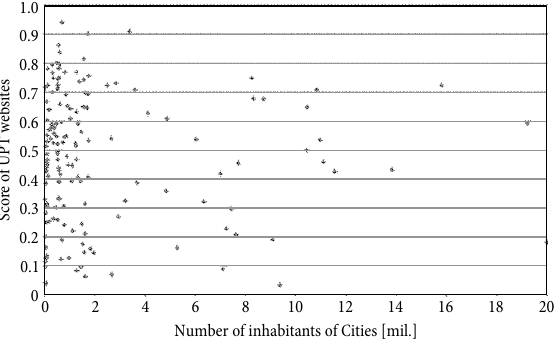
Fig. 5. Relation between number of inhabitants on city and UPT websites scores Box graph of more variables Categories of cities